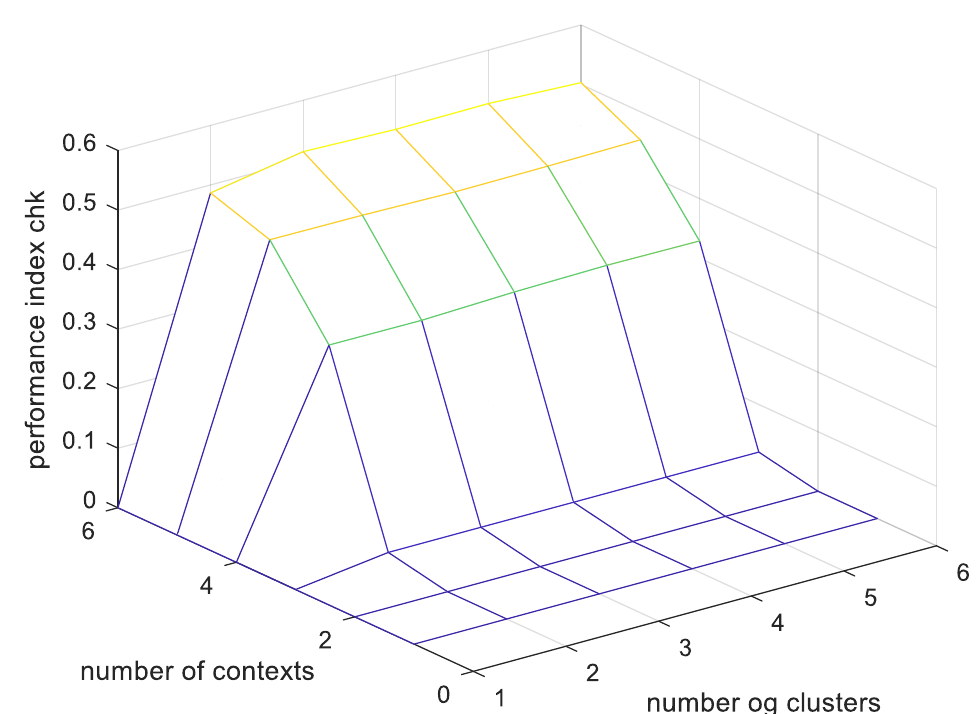
Figure 20. Comparison of the output value of the existing AGM with the actual output value (con- text is created equally, the number of contexts = 6, the number of clusters = 6).